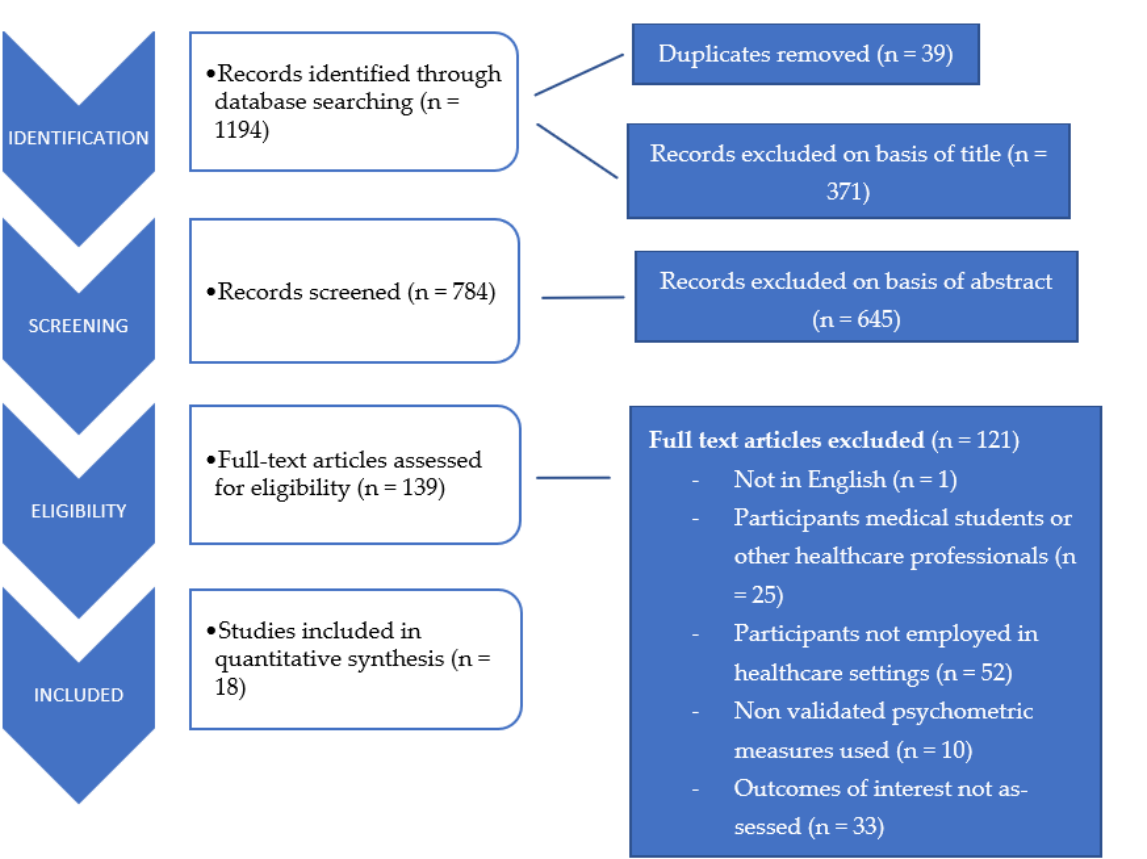
Figure 1. Study selection process.